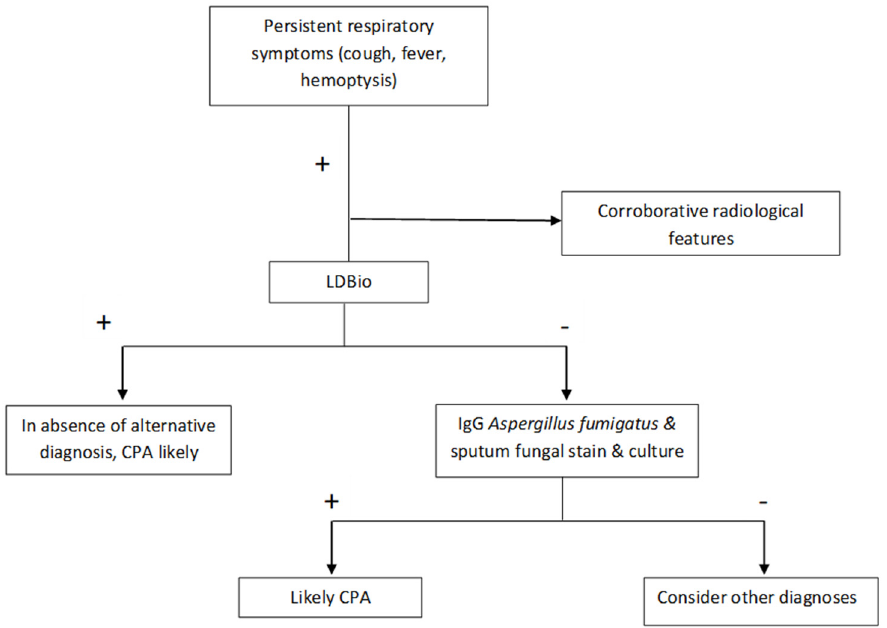
Figure 4. Proposed algorithm for utilising LDBio LFA in the diagnostic algorithm. Table 6. Characteristics of different studies reporting diagnostic performances of LDBio